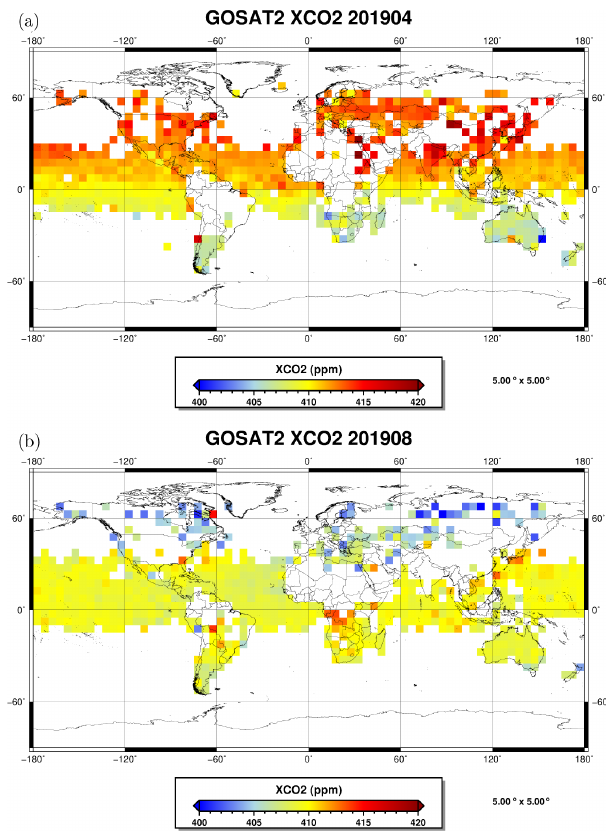
Figure 12. Example for gridded GOSAT-2 XCO 2 data. (a) April 2019. (b) August 2019.